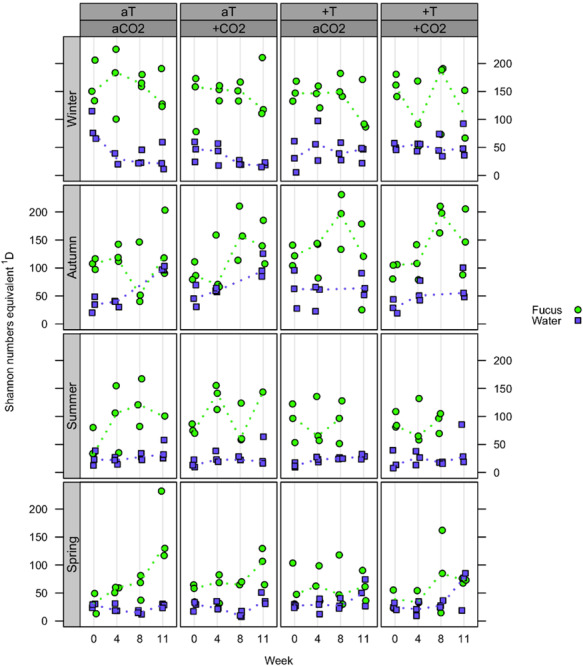
Effective OTU richness (alpha diversity). Distribution of Shannon numbers equivalents 1D at OTU level concerning Fucus vesiculosus biofilm (green circles) and water samples (blue squares) after 0, 4, 8, and 10/11 weeks of treatment during spring, summer, autumn, and winter, respectively, in the Kiel Benthocosms at four different conditions (see section “Materials and Methods”; T, temperature; CO2, pCO2; a, ambient; +, increased). Dots represent 1D of each single sample and dotted lines connect the medians (n = 3) between weeks.